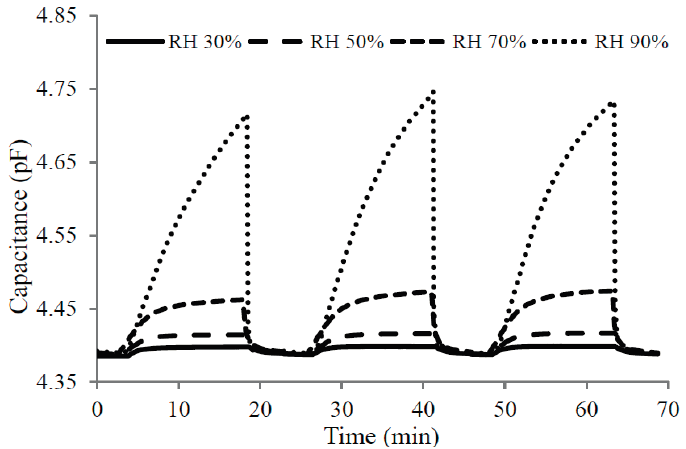
Figure 10. Reproducible Results for the purging experiment for Cu(bdc)·xH 2 O